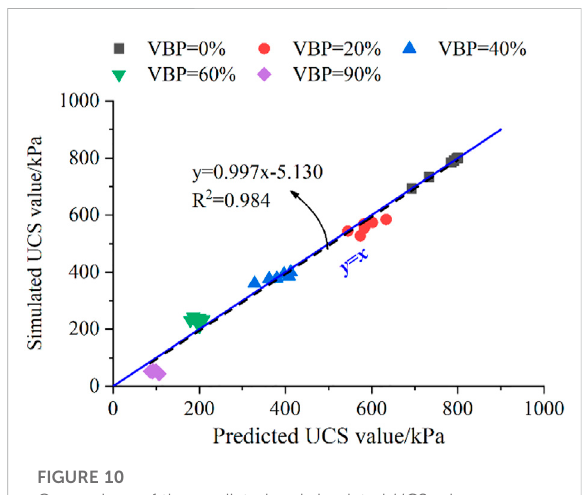
FIGURE 10 Comparison of the predicted and simulated UCS